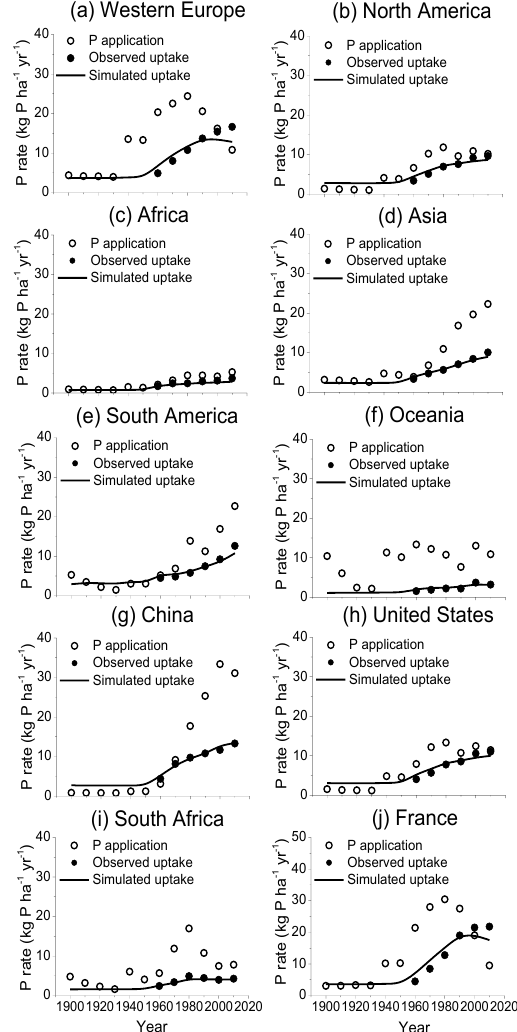
Figure 2. Trends of annual P application (including P from manure and fertilizer), historical P uptake and simulated P uptake in crop- land for the period 1900–2010 in the continents and world regions of western Europe (a) , North America (b) , Africa (c) , Asia (d) , South America (e) , and Oceania (f) , and the countries of China (g) , the United States (h) , South Africa (i) , and France (j) . Open and closed dots refer to P application, and observed P uptake rates from FAO validation data. Solid lines refer to simulated P uptake rates.